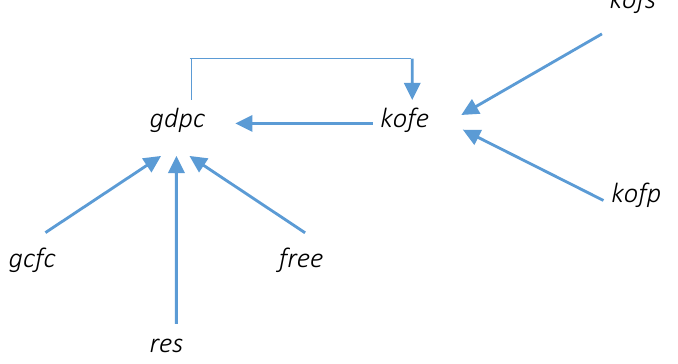
Figure 1. Direct and reverse relationship between growth and economic